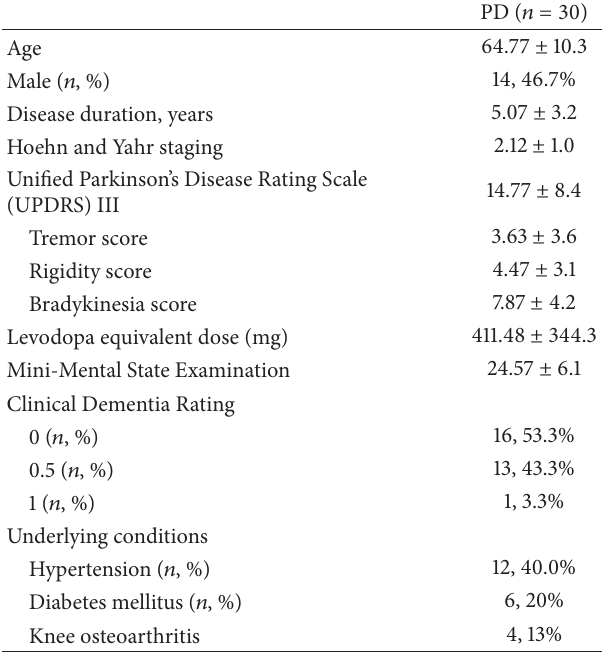
Table 1: Demographic data of patients with Parkinson’s